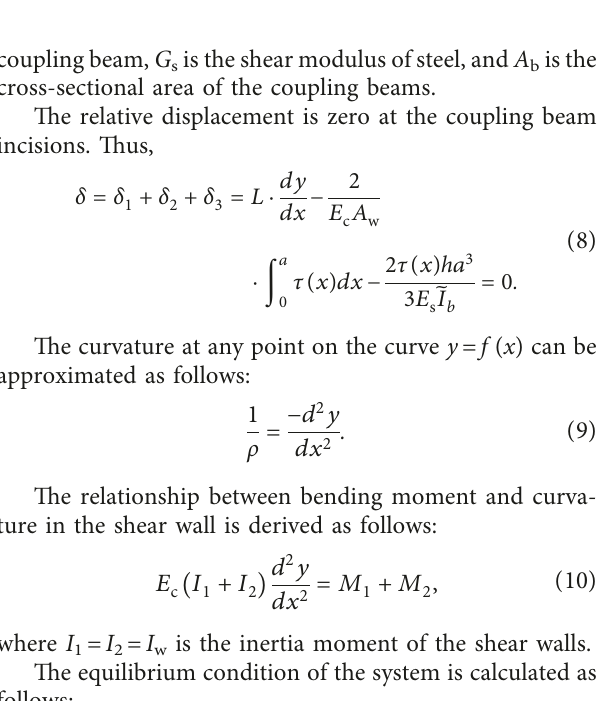
Figure 3: Base reactions under horizontal loads. Figure 4: Base